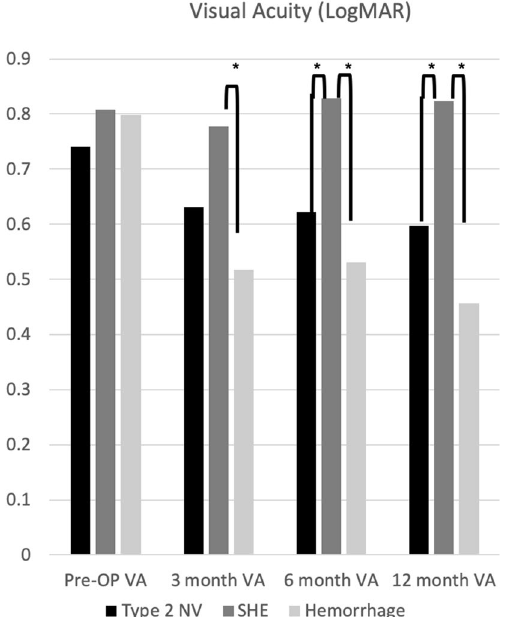
Figure 3. Visual acuity according to different SHRM types after 1 year of treatment. *p < 0.05 compared with baseline visual acuity. SHRM subretinal hyperreflective material, OP operation, VA visual acuity, NV neovascularization, SHE subretinal hyperreflective exudation.